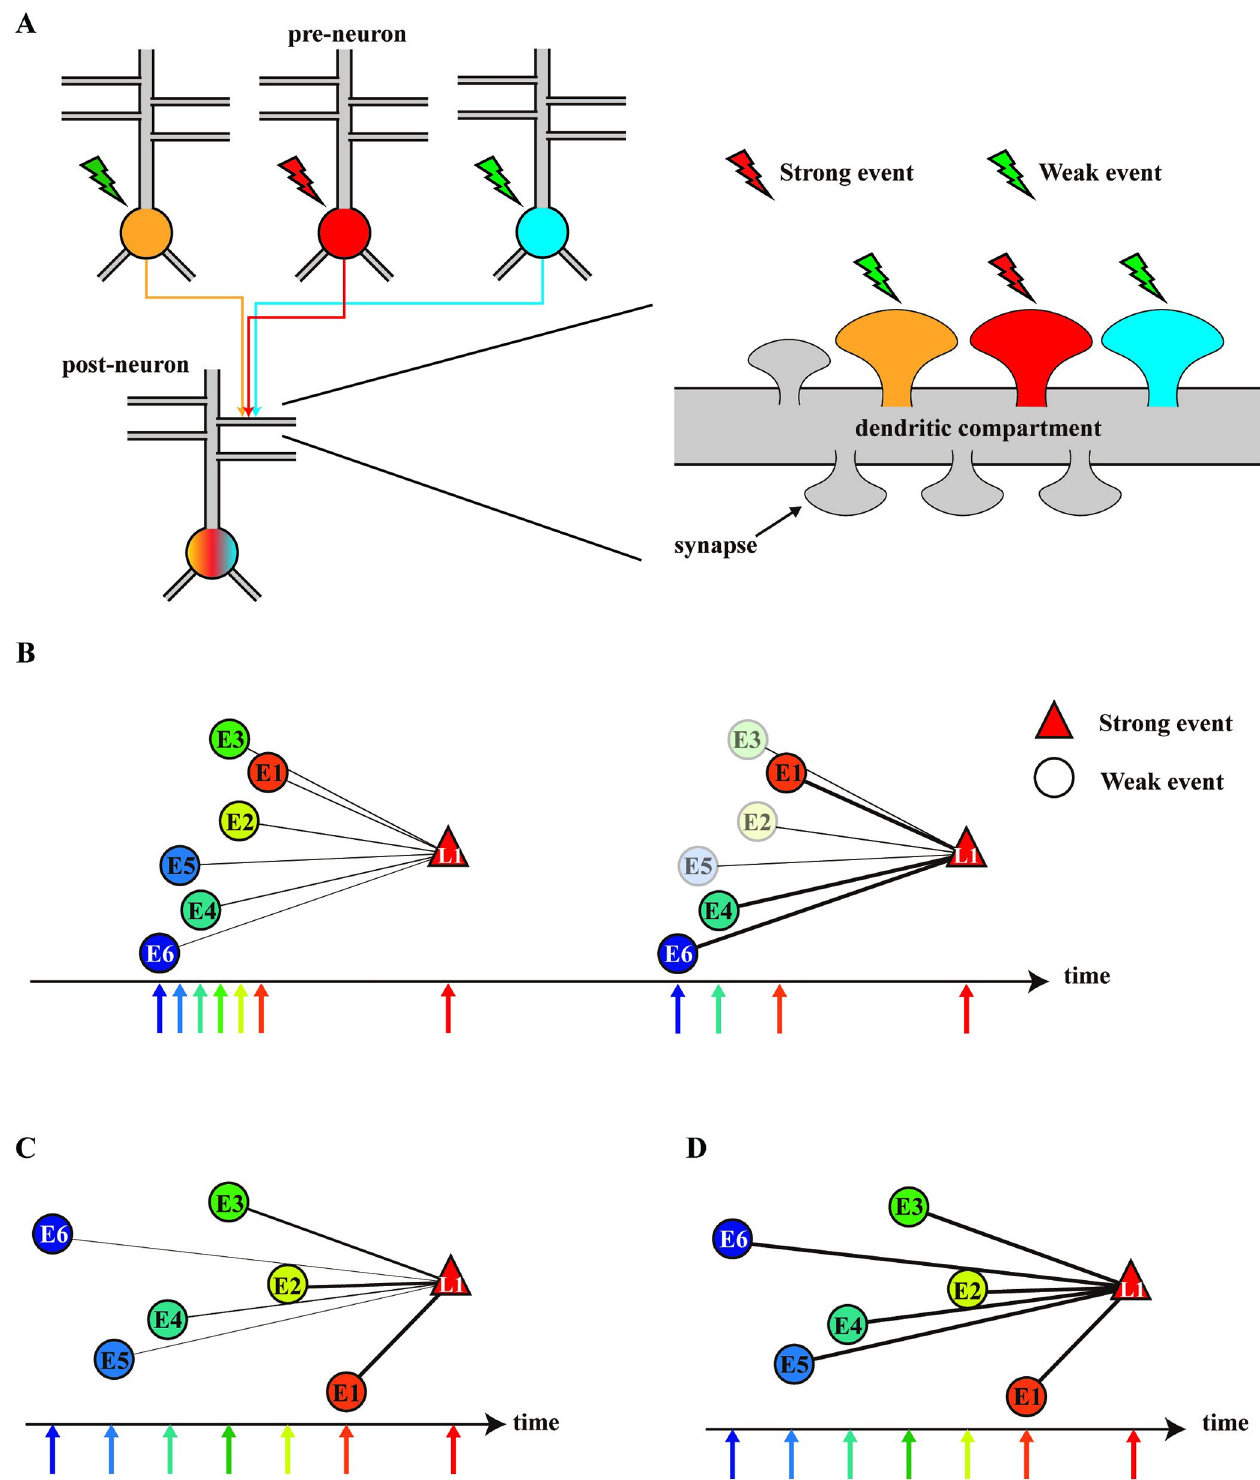
Fig 9. Schematic diagram of the synaptic coupling rules with competing PRP captures. (A) Illustration of synapse clustering. Each of the three preneurons is activated in response to a different event. These preneurons form spatially restricted synaptic clusters on the dendrites of the post-neuron, and the post- neuron contributes to the association of the three events. (B) If the stimulus interval is short, then each weak event is moderately associated with a strong event. In this case, the weak event, which occurs close to the strong event again, is strongly associated. (C) When the stimulus interval is long, weak events close to the